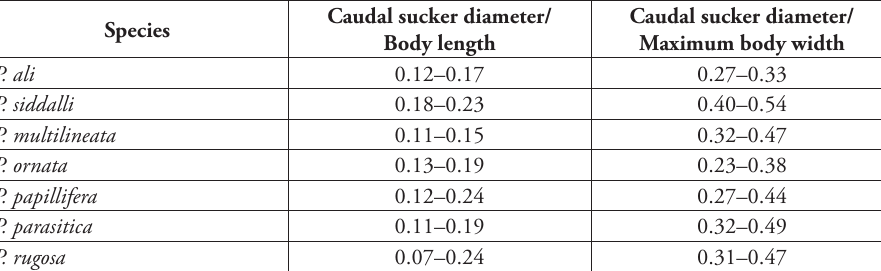
Table 1. Ratio of diameter of caudal sucker to body length and width for seven species in the genus Placobdella